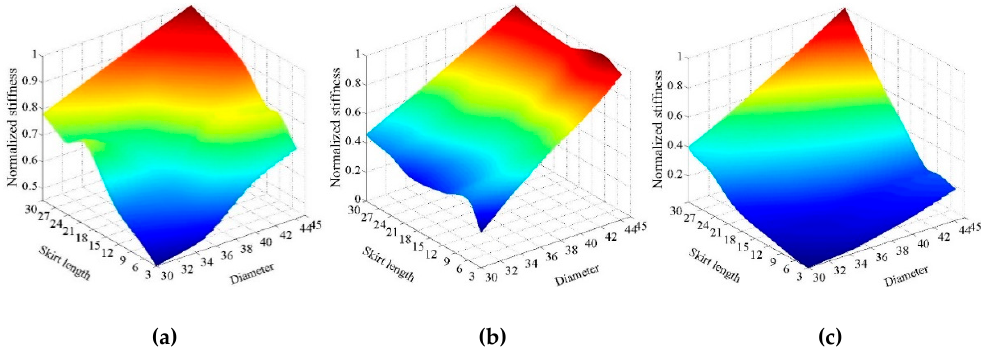
Figure 21. Variation of three dynamic stiffness coefficients at dimensionless excitation frequency of 5: ( a ) Horizontal stiffness; ( b ) coupling stiffness; ( c ) rocking stiffness.